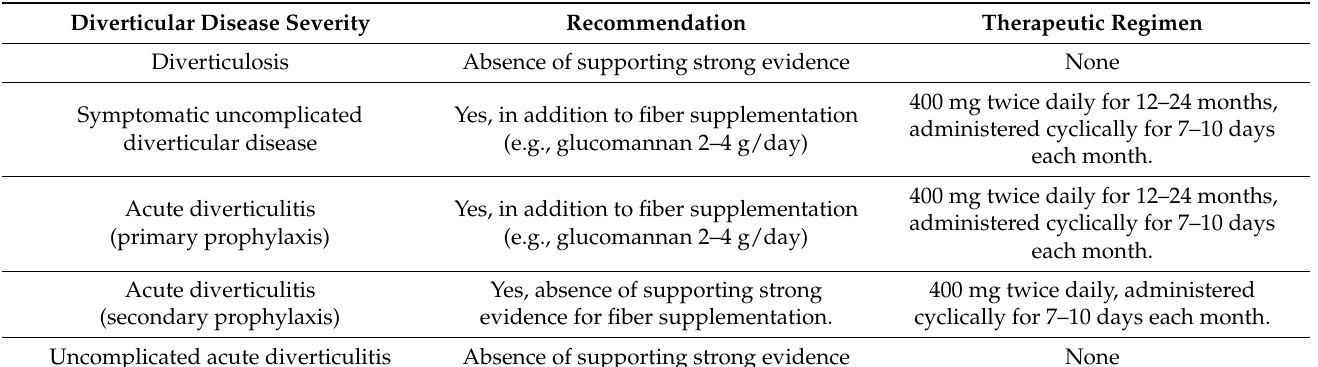
Table 1. Recommendation on current use of rifaximin in diverticular disease. Adapted from Italian Society of Gastroenterology (SIGE) position paper